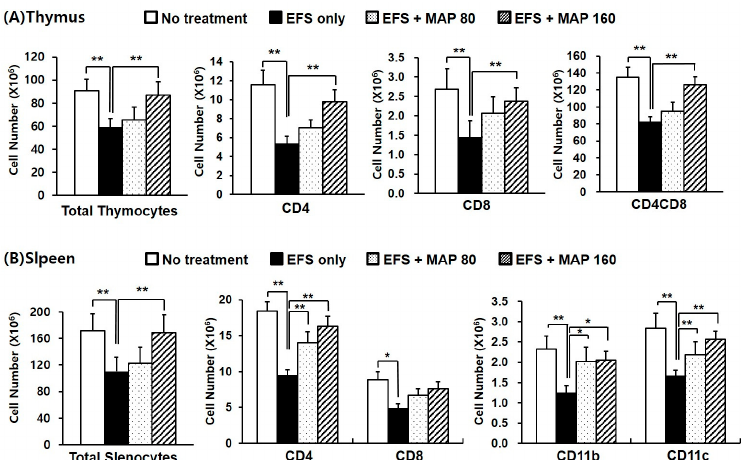
Figure 2. Protective effect of MAP against chronic EFS stress-induced disturbance in thymocyte and splenocyte cellularity. Mice are grouped as described in Figure 1. Lymphocyte subsets of the thymus ( A ) and spleen ( B ) were analyzed using flow cytometry, in which 10,000 cells were scored. Values are means ± SEM of three experiments, n = 7. * p < 0.05, ** p < 0.01 compared with control.